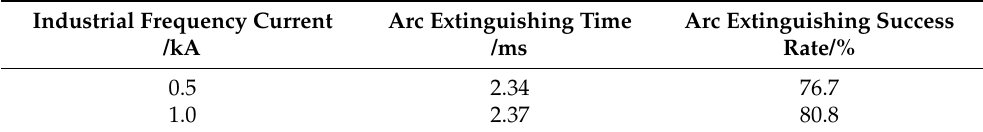
Table 1. Gas blowing arc extinguishing gap arc extinguishing